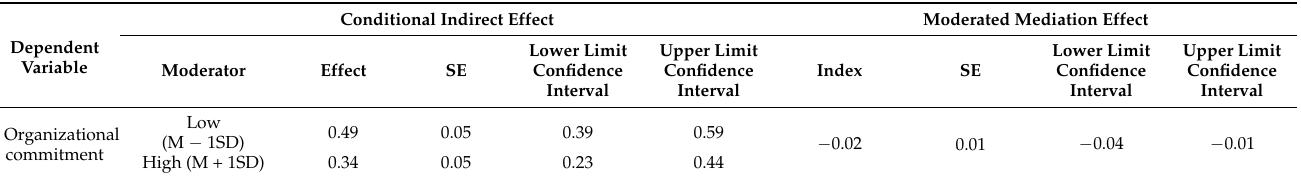
Table 4. The results of moderation effect analysis.